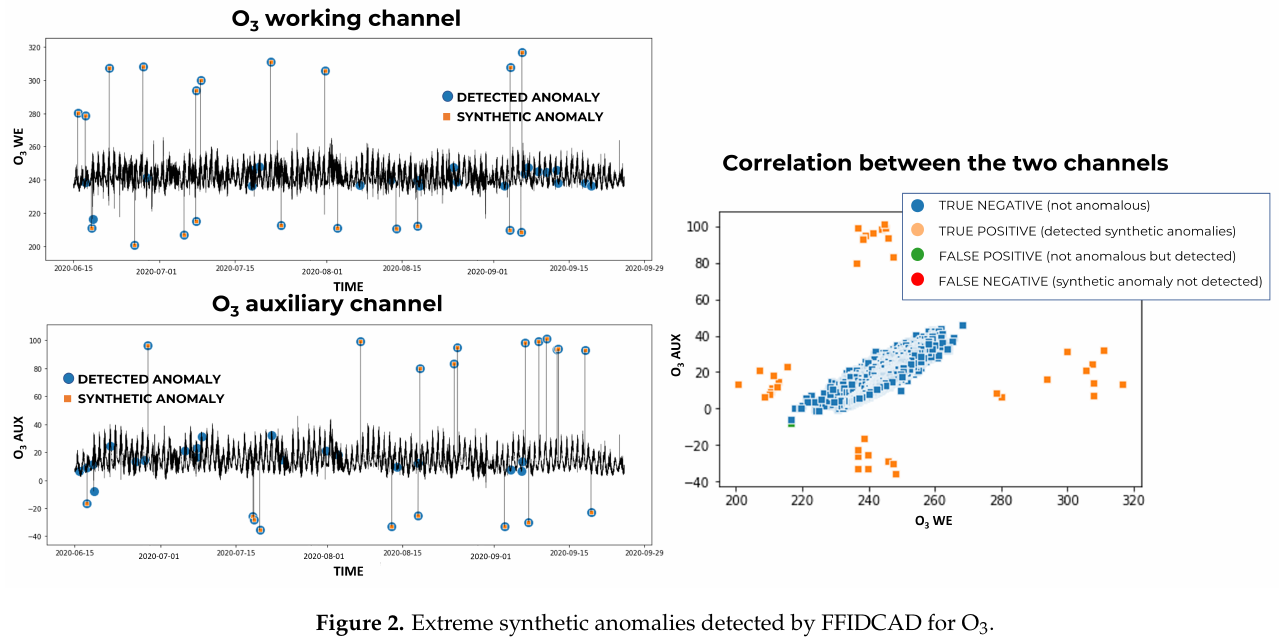
Figure 2. Extreme synthetic anomalies detected by FFIDCAD for O 3 .